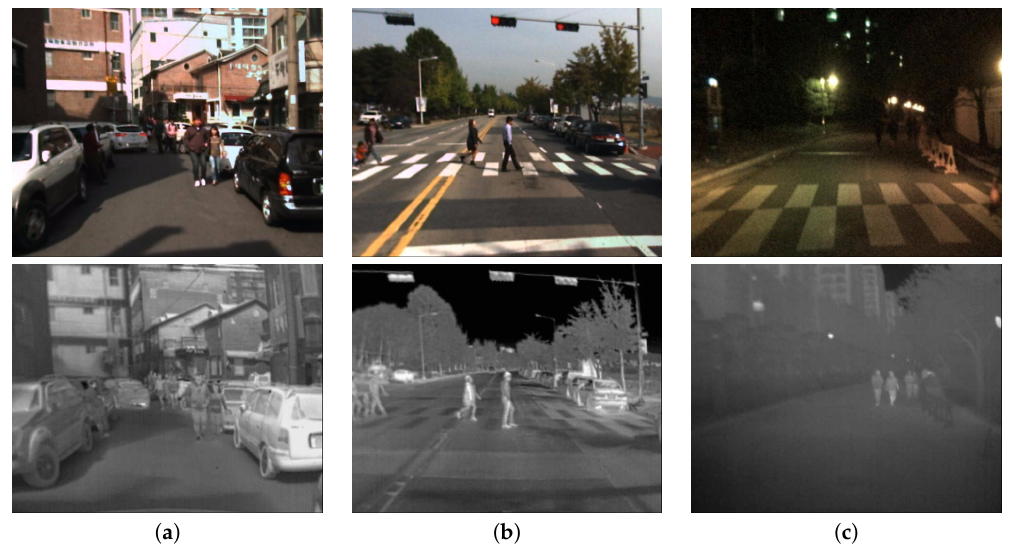
Figure 1. Examples of various light conditions and their influence on the visibility of people in visible light (first row)/thermal (second row) images: ( a ) Warm day with good visibility in bright regions and low contrast in the shadow in RGB; low contrast in thermal range. ( b ) Good pedestrian visibility in both visible light and thermal images. ( c ) Night scene with low visibility in RGB and pedestrians visible in